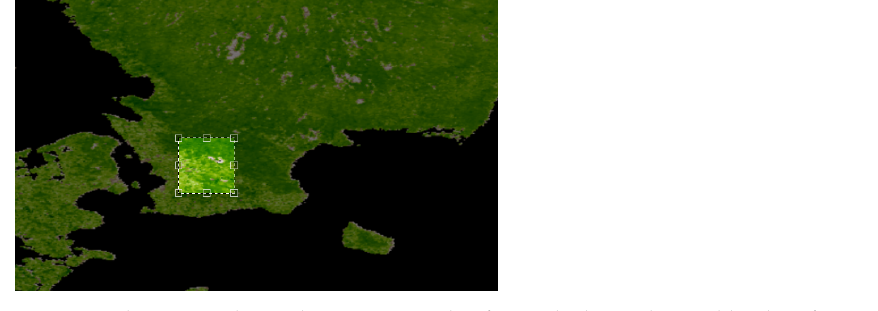
Figure 4. The square shows the area in Sweden from which we obtained land surface temperature in images of 60 × 60 pixels, with resolution (per pixel) of 1 km.